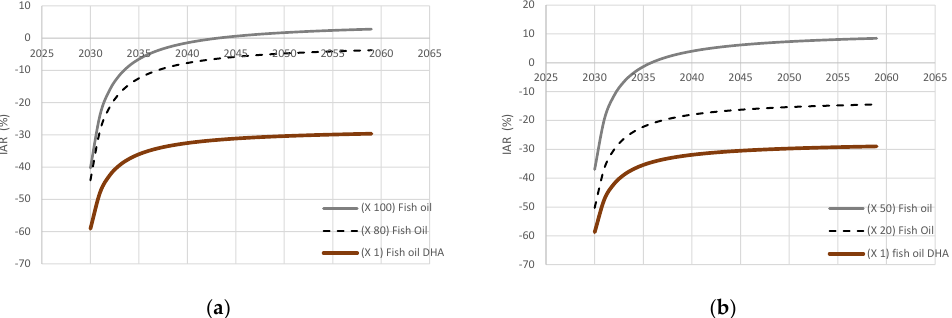
Figure 16. IAR economic indicator as a function of fish oil DHA reference cost, ( a ) 0.06 g/L/h and 50% oil content, ( b ) 0.14 g/L/h and 50% oil